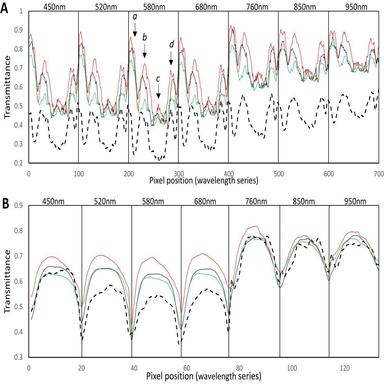
Concatenated transmittance spectra extracted by multispectral imaging. A: nematode body; B: eggs. - - Control; L; M; H. Vertical bars indicate limits of the spectra within a a given slice of the multispectral image corresponding to a wavelength. Letters indicate the peaks related to anatomical orifices on a nematode body.